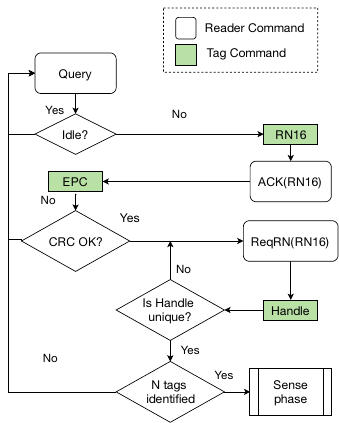
Figure 6. Identification Phase of sFSA using the unique handle